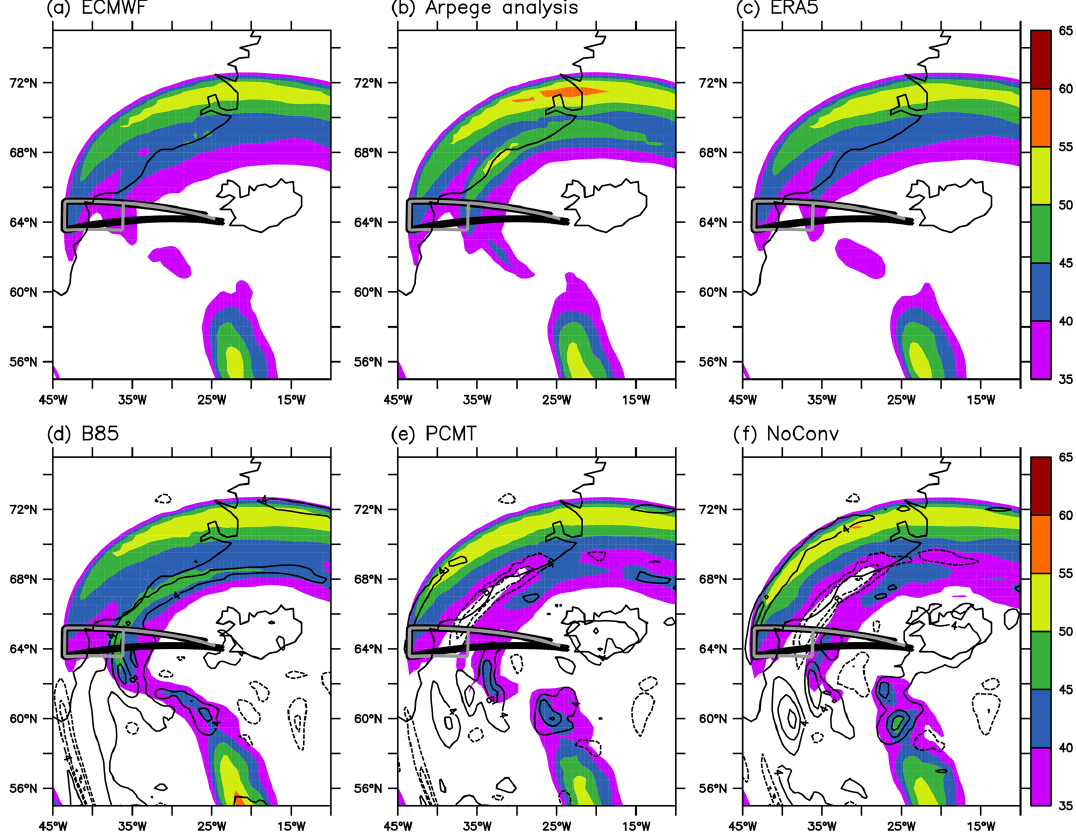
Figure 9. Wind speed (shadings; units: ms − 1 ) at 300hPa at 12:00UTC on 2 October for the (a) ECMWF-IFS operational analysis, (b) ARPEGE operational analysis, (c) ERA5 reanalysis, (d) B85 run, (e) PCMT run and (f) NoConv run. In panels (d) – (f) , the black contours represent the wind speed anomalies (interval: 4ms − 1 ) of the three runs with respect to the ECMWF-IFS operational analysis. The black and grey lines correspond to the SAFIRE and DLR Falcon flights that occurred between 09:00 and 12:00UTC on 2 October in an anticlockwise